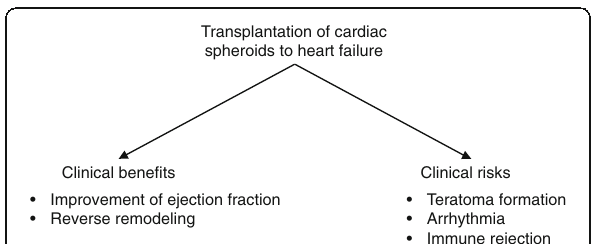
Fig. 2 Clinical benefits and risks of cardiac regenerative